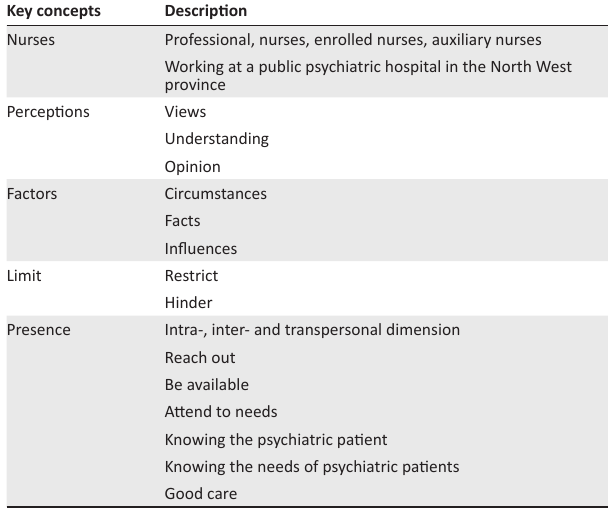
TABLE 1: Key concepts.